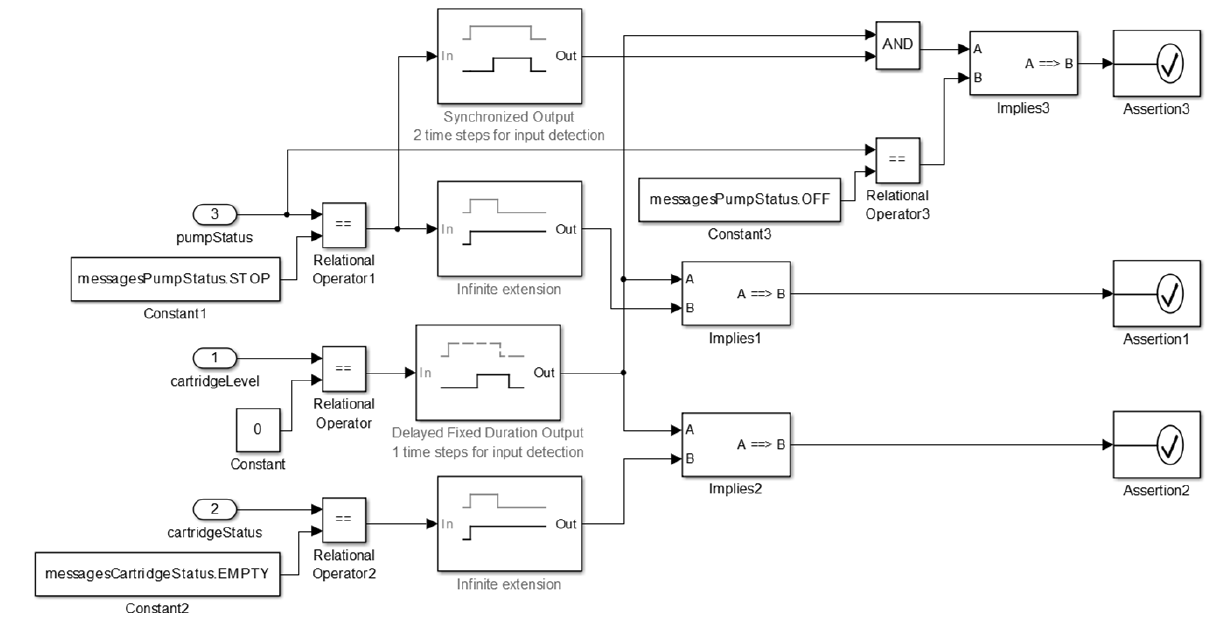
Figure 26. Safety Property